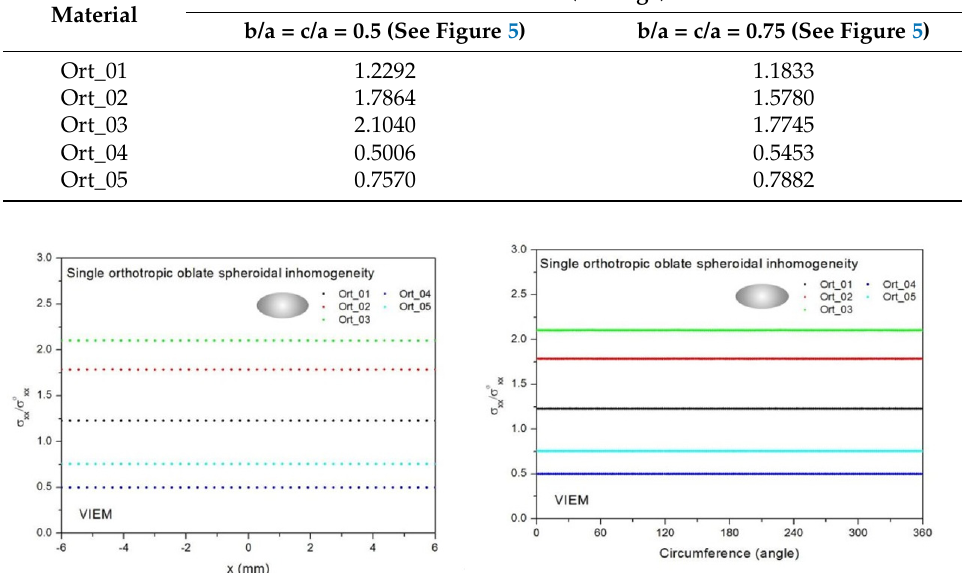
Figure 20. VIEM results for the normalized tensile stress component ( σ xx / σ o xx ) along ( left ) the x–axis inside and ( right ) the circumferential direction of the orthotropic oblate spheroidal inclusions (Ort_01, Ort_02, Ort_03, Ort_04 and Ort_05) with b/a = c/a = 0.5 (a = 6 mm) under uniform remote tensile loading.